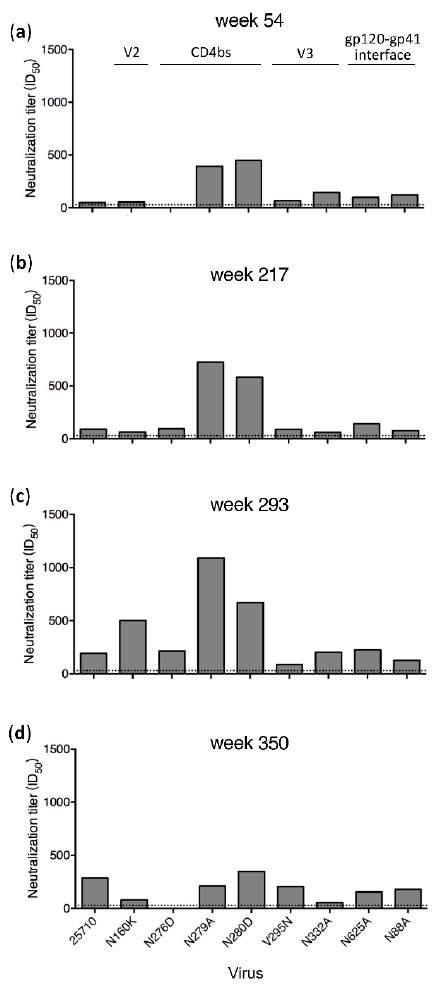
Figure 1. Neutralization specificities of longitudinal plasma from G1020R. Neutralization activities of plasma samples from weeks 54 ( a ), 217 ( b ), 293 ( c ) and 350 ( d ) post infection from G1020R were determined using the wild type 25710 and its env mutants (N88A, N160K, N276D, N279A, N280D, V295N, N332A and N625A). The dotted line indicates the lowest dilution (1:30) for the neutralization